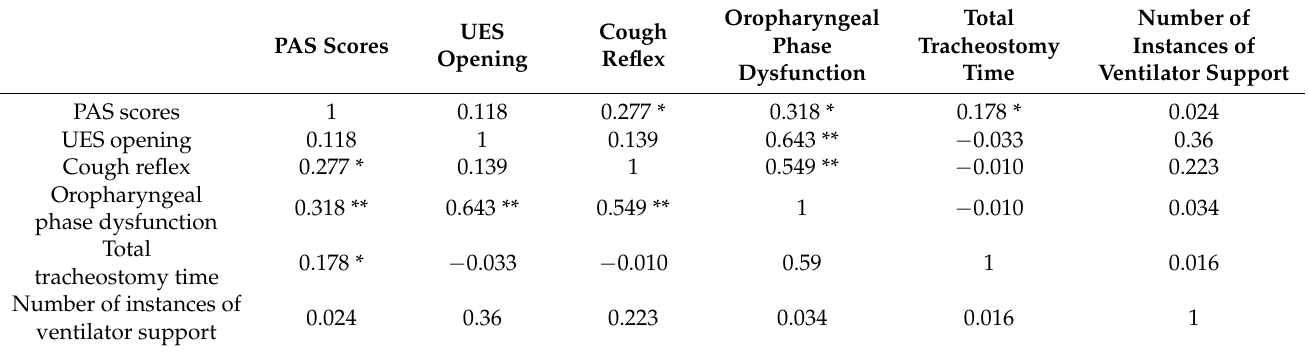
Table 7. The correlation analysis of tracheostomy and